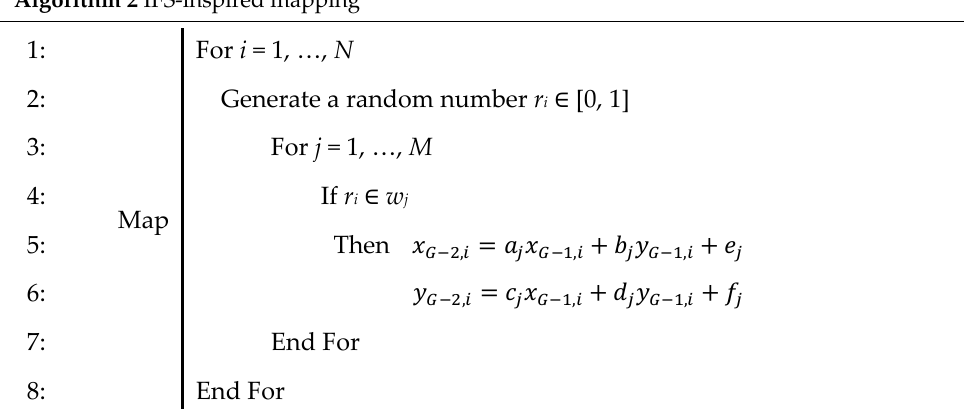
Algorithm 2: IFS-inspired Algorithm 2 IFS-inspired mapping